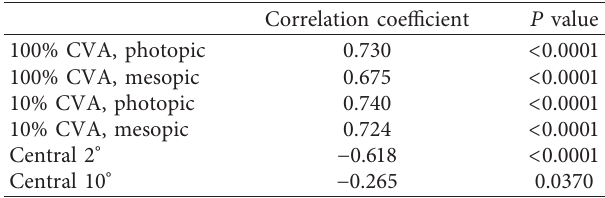
Table 4: Correlations between preoperative contrast visual acuity, preoperative retinal sensitivity, and the amount of improvement in CVA and retinal